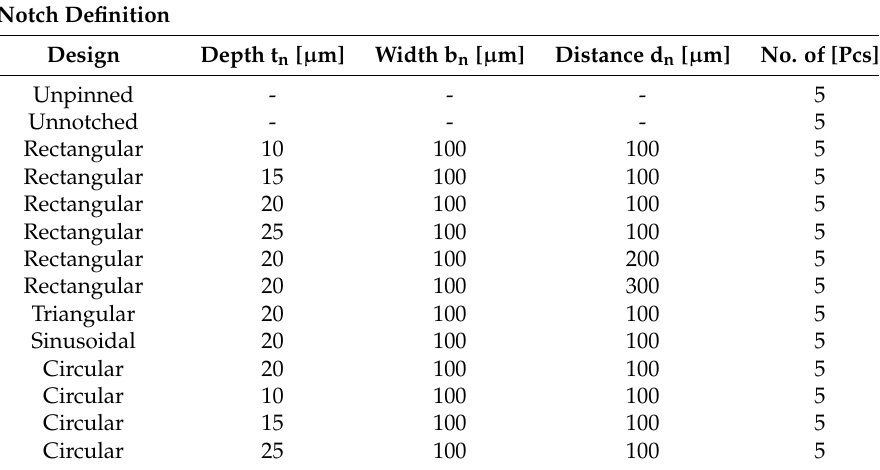
Table 1. Details of investigated notch designs and number of specimens tested.